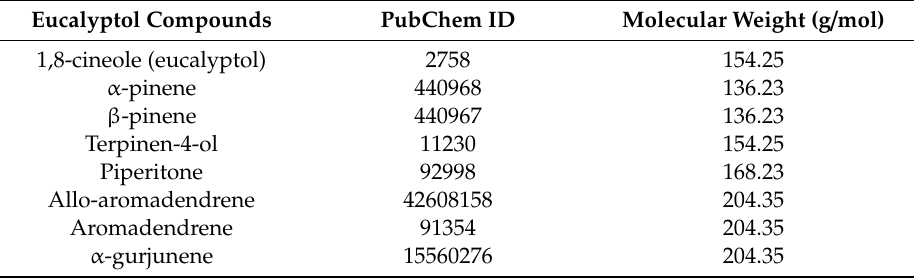
Figure 1. Two molecular dimensional structures of the eucalyptus compounds used in this study: ( a ) 1, 8-cineole (eucalyptus), ( b ) α -pinene, ( c ) β -pinene, ( d ) terpinen-4-ol, ( e ) piperitone, ( f ) allo-aromadendrene, ( g ) aromadendrene, and ( h ) α -gurjunene. Table 1. PubChem ID and molecular weight of the selected compounds.